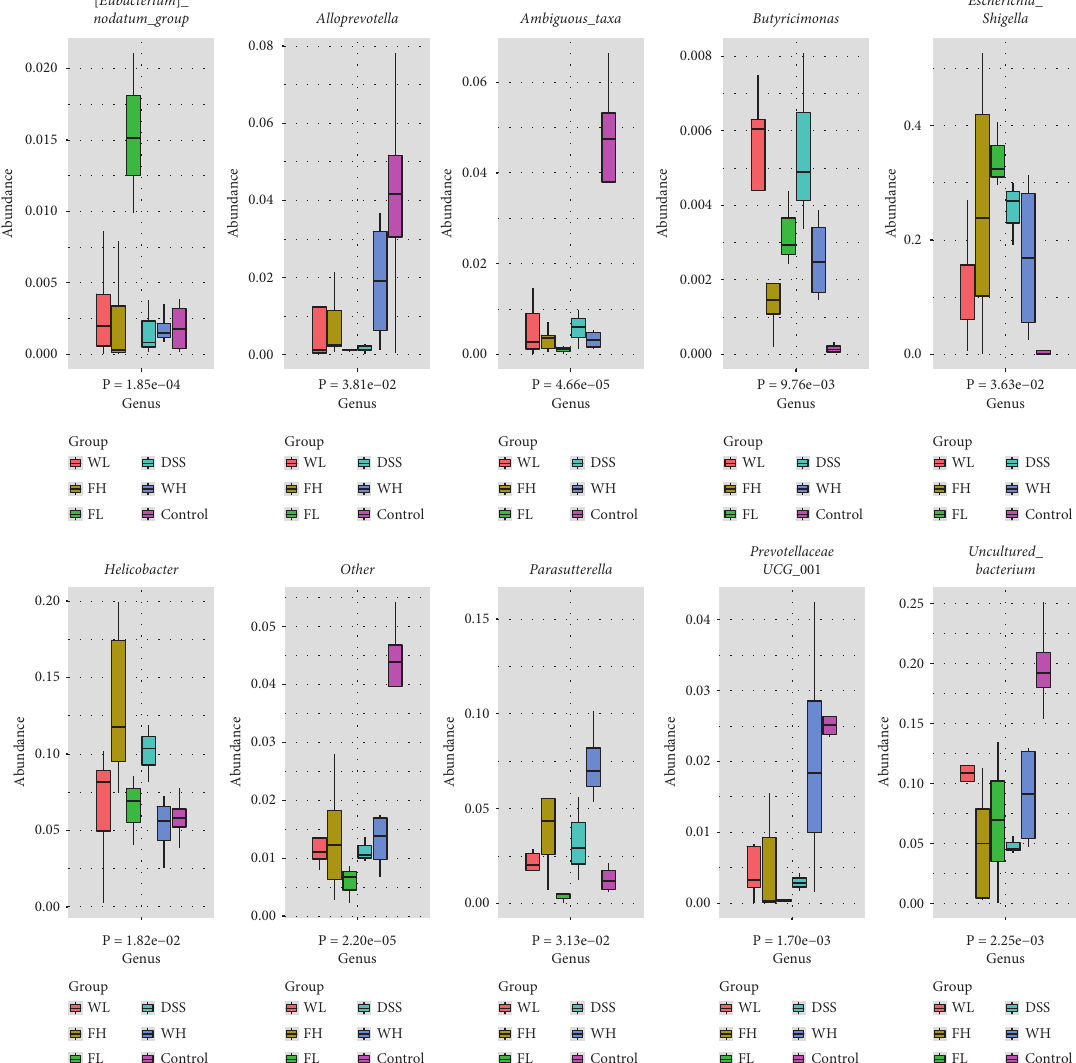
Figure 6: Boxplot analysis of relative abundance of the top 10 species among different groups at the genus